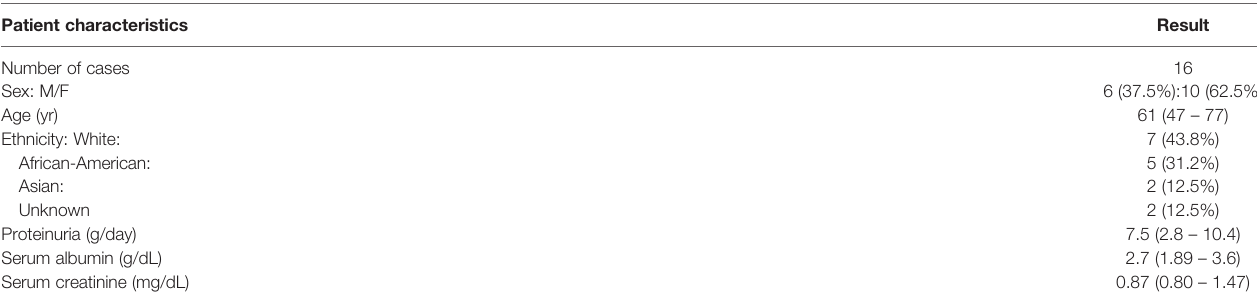
TABLE 1 | Demographic and clinical characteristics of anti-THSD7A positive